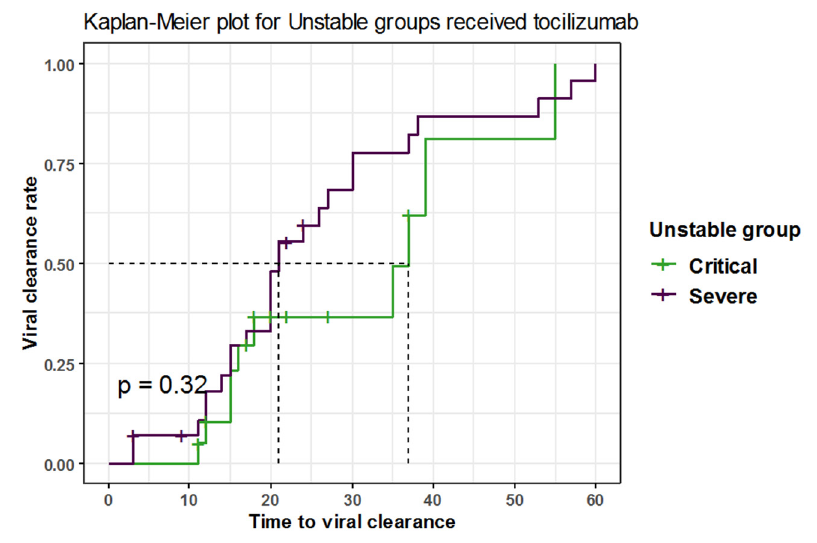
Figure 2. Kaplan–Meier plot for unstable groups receiving tocilizumab.